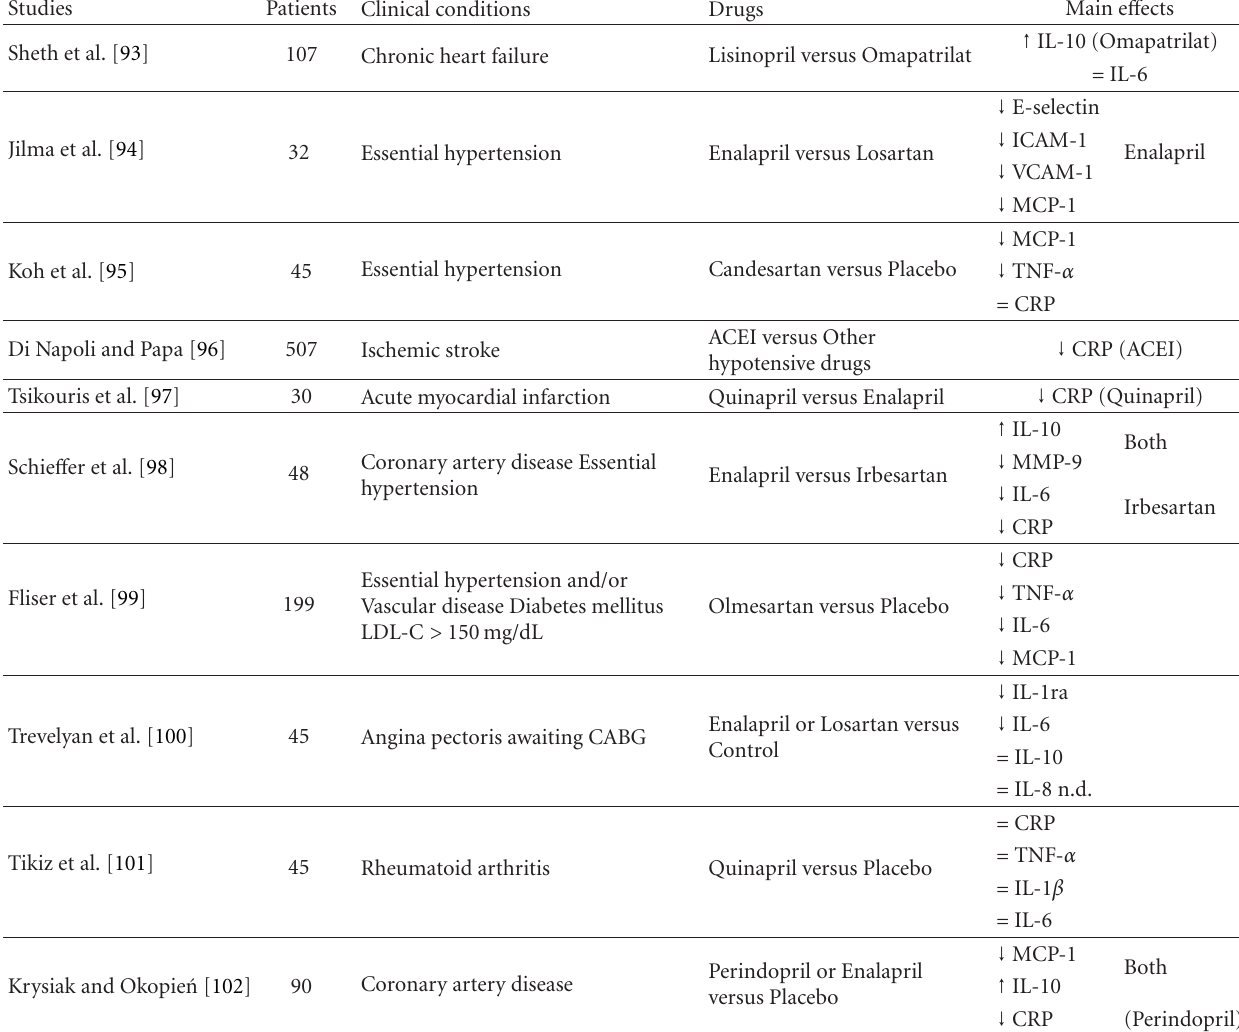
Table 1: Clinical studies evaluating e ff ects of RAS blockade on circulating inflammatory markers. When two active drugs are administered, the e ff ects demonstrated are with respect to basal values; when an active deug and placebo are used, the comparisons are between the two arms. CABG: coronary artery bypass grafting; ACEI: ACE